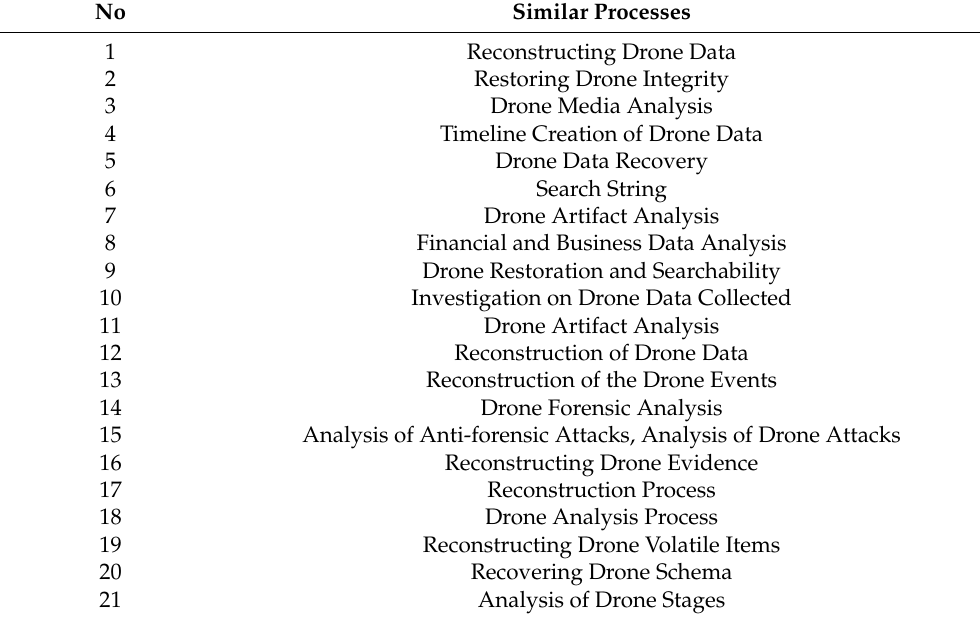
Table 4. Reconstruction and analysis